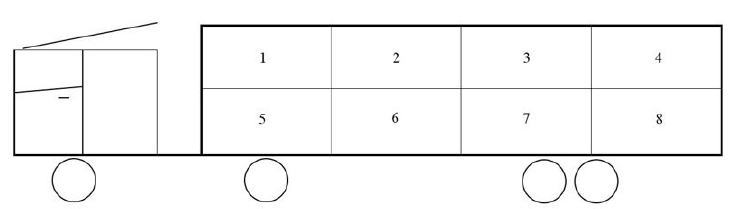
Figure 1. Schematic presentation of the trailer with the numbered trailer pens. Pigs transported: n = 849 in trailer pen 1; n = 1169 in trailer pen 2; n = 1197 in trailer pen 3; n = 963 in trailer pen 4; n = 23 in trailer pen 5; n = 190 in trailer pen 6; n = 336 in trailer pen 7; n = 36 in trailer pen 8.